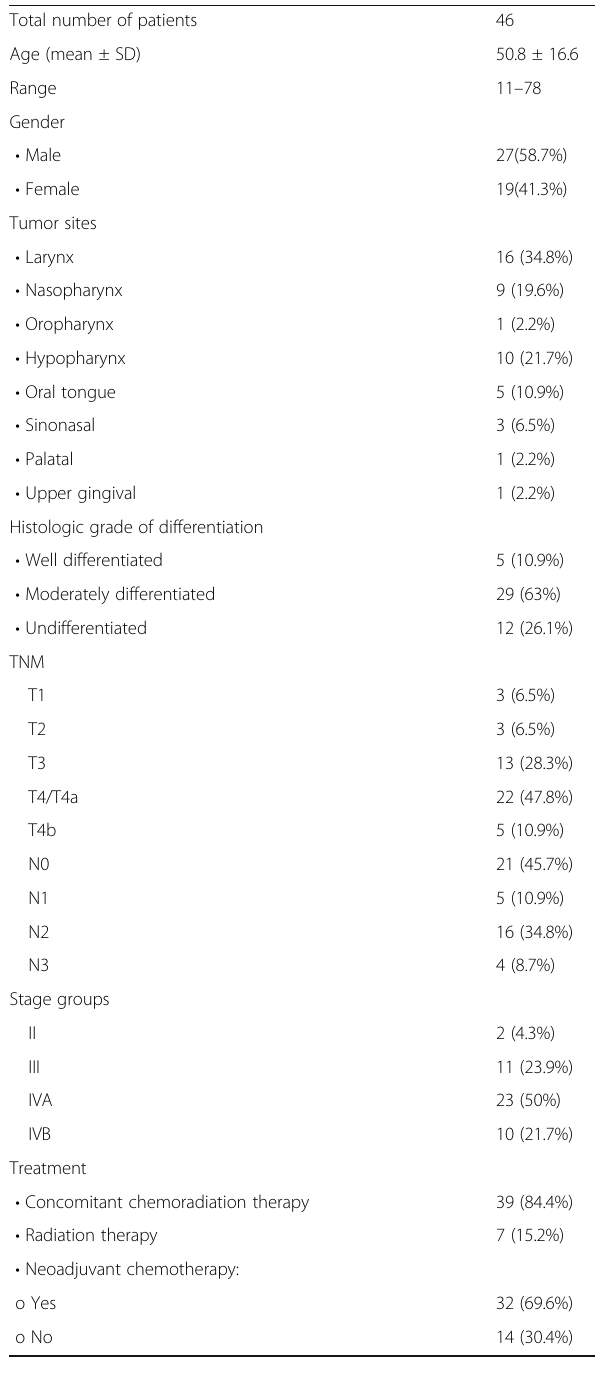
Table 1 Patients characteristics